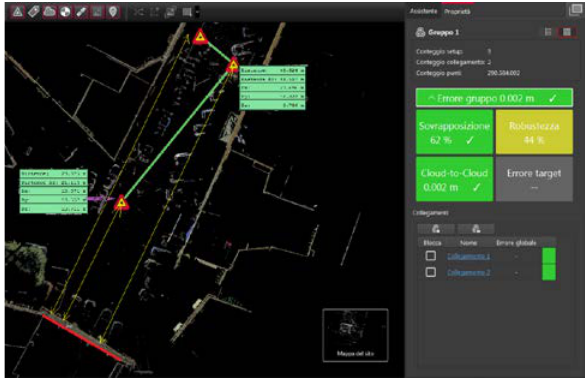
Figure 5. TLS survey processing information